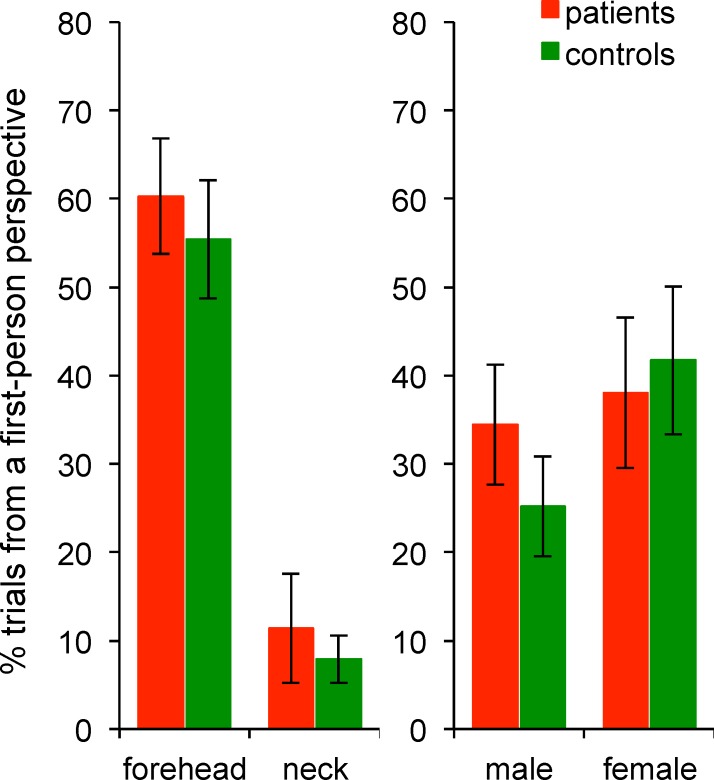
Results from the graphaesthesia task (Experiment 2).Histograms on the left represent the main effect of the within-subject factor Site of stimulation and histograms on the right represent the main effect of the between-subject factor Group. Data from patients and controls are shown separately for illustration purposes only. Histograms represent the mean of the percentage of trials perceived from a first-person perspective and vertical bars represent the standard error of the mean.